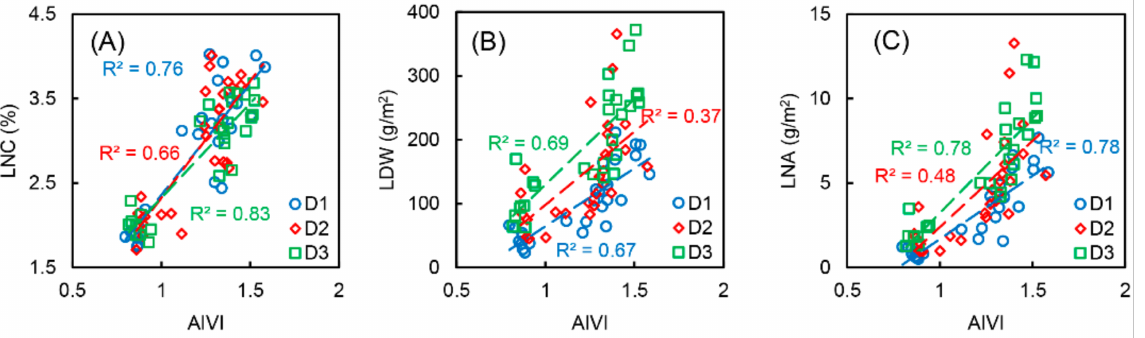
Figure 11. Correlation of AIVI with LNC ( A ), LDW ( B ), and LNA ( C ) under different row widths; D1, D2, and D3 represent row widths of 50, 35, and 20 cm, respectively. The RVI contains information about both chlorophyll and canopy structure.